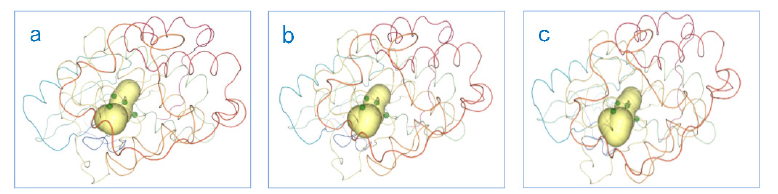
Figure 17. The PCD 3D View shows several keyframes: the dynamic changes of cavities and amino acids over time. The yellow area in the figure represents the cavity, and the small green dots represent the amino acids. From figure ( a – c ), we can find that the shape of the cavity has changed, and the positions of these amino acids has also